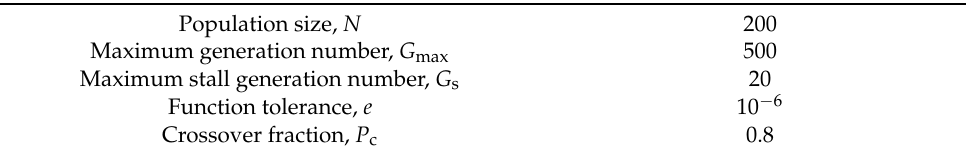
Table 2. Parameters of the genetic algorithm.